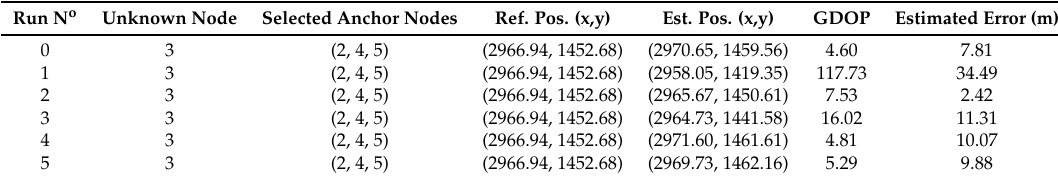
Table 1. Closest nodes approach.